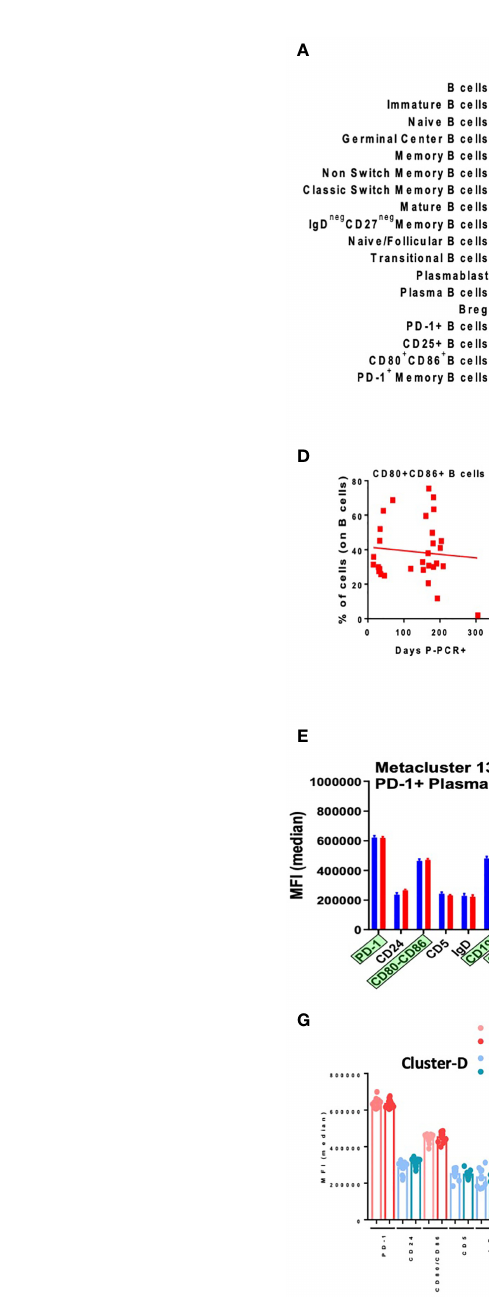
FIGURE 4 | Manual gating and high-dimensional fl ow cytometry unsupervised analysis in B-cell panel. (A) Heat map of the pairwise comparison between recovered COVID-19 (COV) and healthy control (CT) individuals of cellular subsets obtained by classical fl ow cytometry analysis. Analysis was performed with the Mann – Whitney U test. The colour scale represents the Z-score on the right Y-axis. Immune population names are represented on the left Y-axis. The left column represents the z-score from the pairwise comparison of the cellular population ’ s percentage (%), and the right column represents the z-score from the pairwise comparison of the absolute numbers (cells/uL, AbsN). The p -value was adjusted by the Benjamini – Hochberg adjustment method for multiple testing. (B) Frequency or AbsN (C) of CD80/CD86+ B- cells in CT and COV individuals. Pairwise comparisons were performed using a Mann – Whitney U-test with Benjamini – Hochberg adjustment for multiple testing. Mean ± SEM. (D) Correlation between days P-PCR+ and frequency of CD80/CD86+ (left panel) and AbsN of CD80/CD86+ B cells (right panel). Spearman ’ s rank-order correlation test with Benjamini – Hochberg adjustment for multiple testing. (E) MFI of cluster 13 was obtained through FlowSOM analysis. One-way ANOVA with Benjamini – Hochberg adjustment for multiple testing. Median ± SEM. (F) The abundance of cluster D was signi fi cantly different between COV and CT individuals and was obtained through CITRUS analysis. One-way ANOVA with Benjamini – Hochberg adjustment for multiple testing. Median ± SEM. (G) MFI of cluster D obtained through CITRUS analysis. One-way ANOVA with Benjamini – Hochberg adjustment for multiple testing. Median ± SEM. (H) Correlation between AbsN of ICOS+ PD-1+ Tfh and the abundance of PD-1+ plasma cells. Spearman ’ s rank-order correlation test with Benjamini – Hochberg adjustment for multiple testing. * p < 0.05 and ** p <